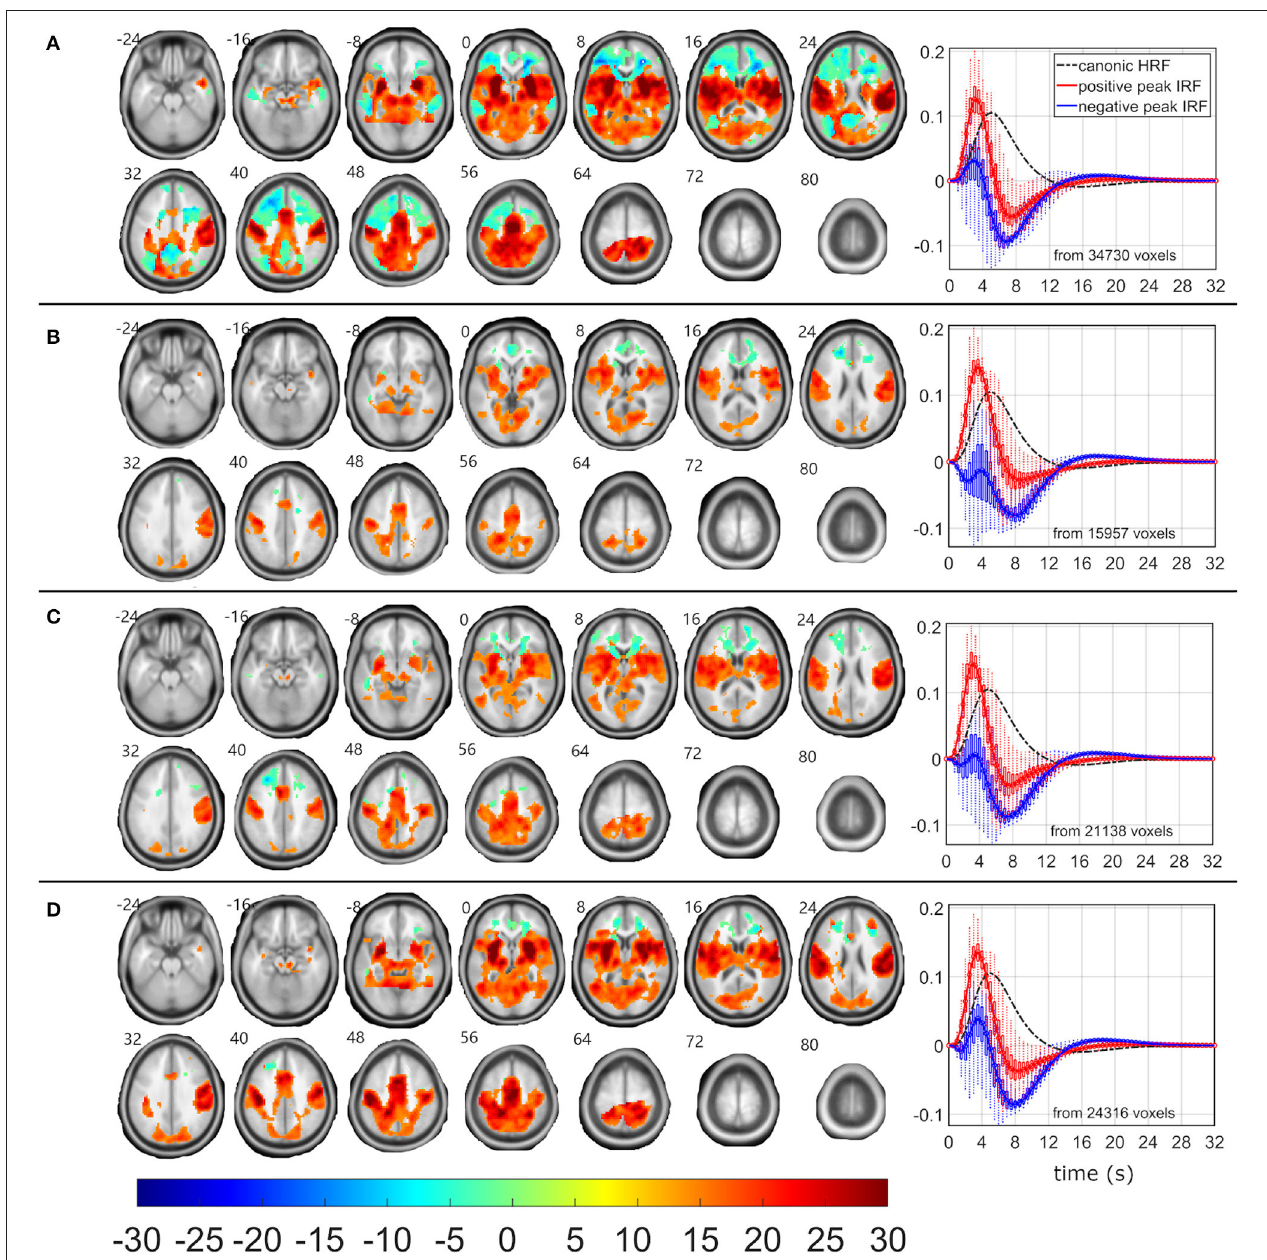
FIGURE 2 | EEG-fMRI F-maps and estimated hemodynamic response functions for all investigated models of the δ 4 pattern. The EEG-fMRI F-map colorbar is the same over all models. HRF, hemodynamic response function; IRF, impulse response function. If HRF demonstrated a reduced peak and an amplified trough (i.e., blue color-coded HRFs) the F -values were assigned with a negative sign. The F-maps were threholded with p < 0.0001, i.e., |F| > 8.1. The voxels with |F| > 12.1 met the condition p FWE < 0.05. The red color coded HRFs were derived from voxels with positive signed suprathreshold F -values. All F-maps are shown following the neurological convention, i.e., left hemisphere on the left side of the axial slice. (A) Absolute spectral. (B) Relative spectral. (C) Absolute spatiospectral. (D) Relative